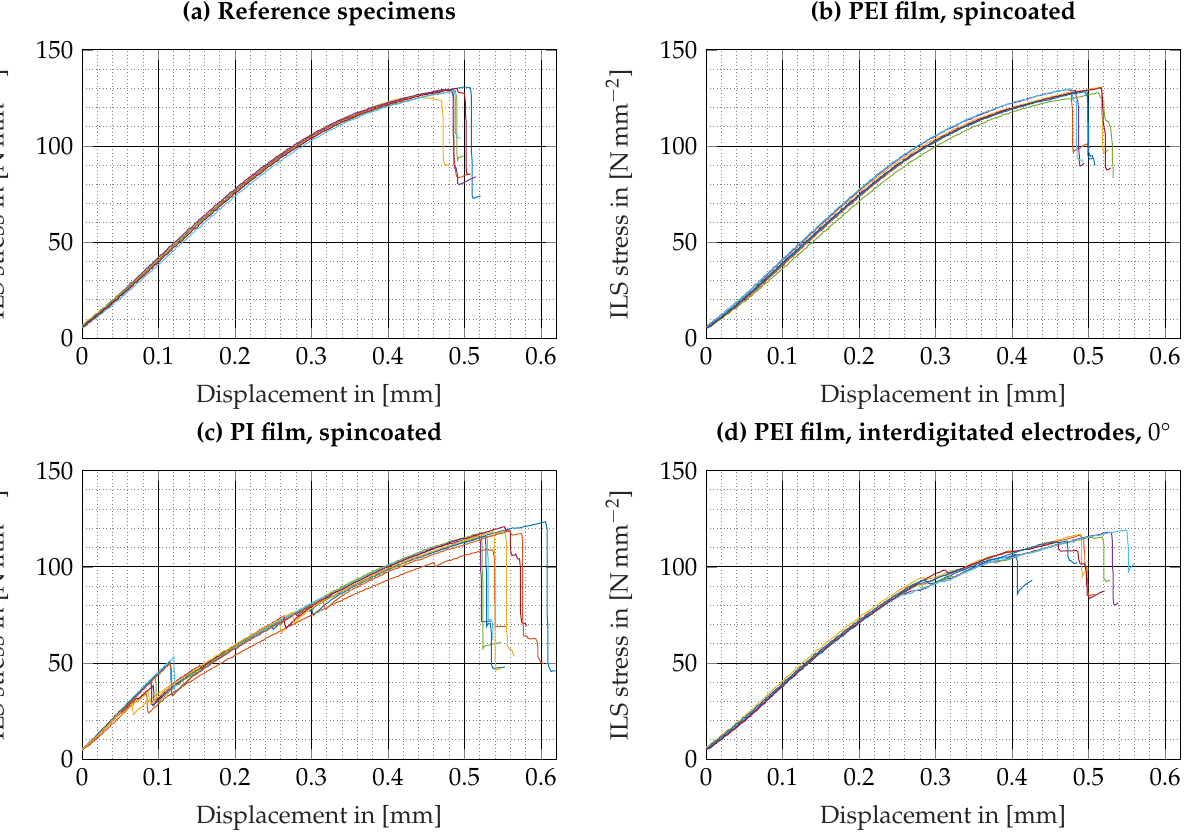
Figure 6. Bending force over displacement curves for four types of failure in ILS specimens: ( a ) Reference specimens. ( b ) PEI film, spincoated, without sensor structures. ( c ) PI film, spin coated, without sensor structures. ( d ) PEI film, spin coated, with interdigitated electrodes, orientated in fibre